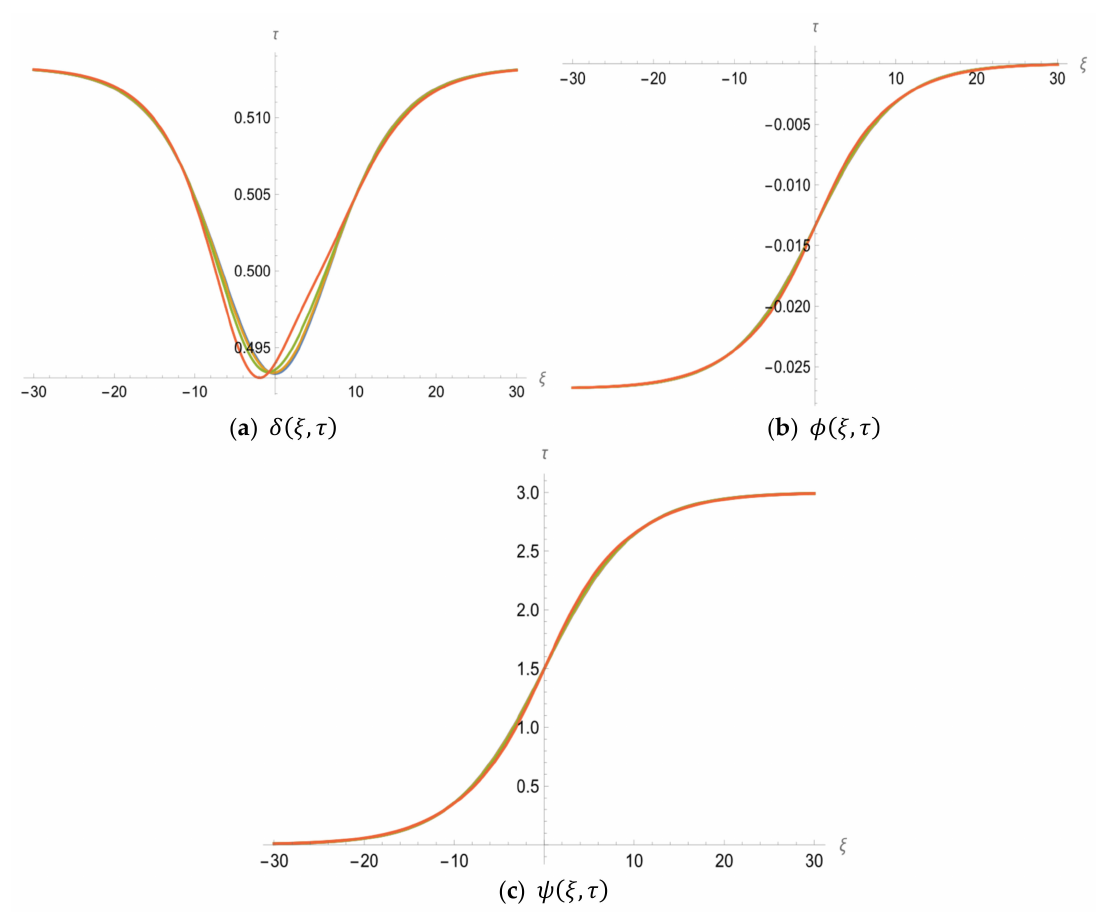
Figure 4. The graph of the 5th LRPSM solutions δ ( ξ , τ ) , φ ( ξ , τ ) , and ψ ( ξ , τ ) for HSC–KdV equation